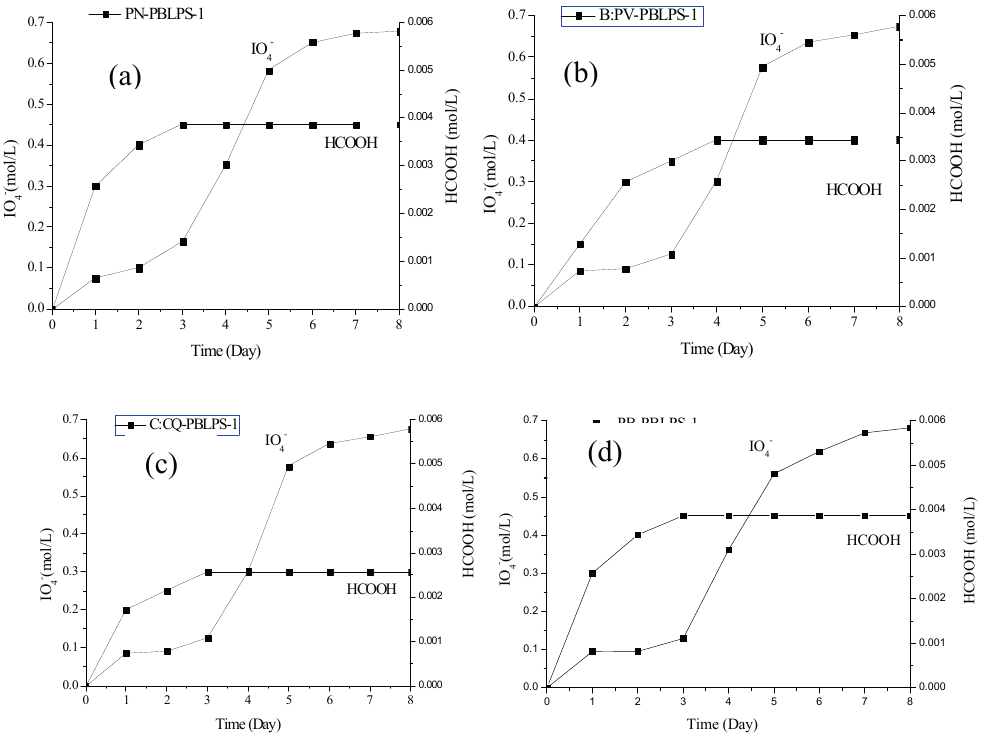
Figure 7. Consumption of IO 4 − and production of HCOO for PBLPS-1 from the four varieties of bamboo leave: ( a ) PN-PBLPS-1 of Phyllostachys nigra (PN) ( b ) PV-PBLPS-1 of Phyllostachys vivax (PV) ( c ) CQ-PBLPS-1 of Chimonobambusa quadrangularis (Fenzi) Makino (CQ) ( d ) PB-PBLPS-1 of Phyllostachys bambusoides